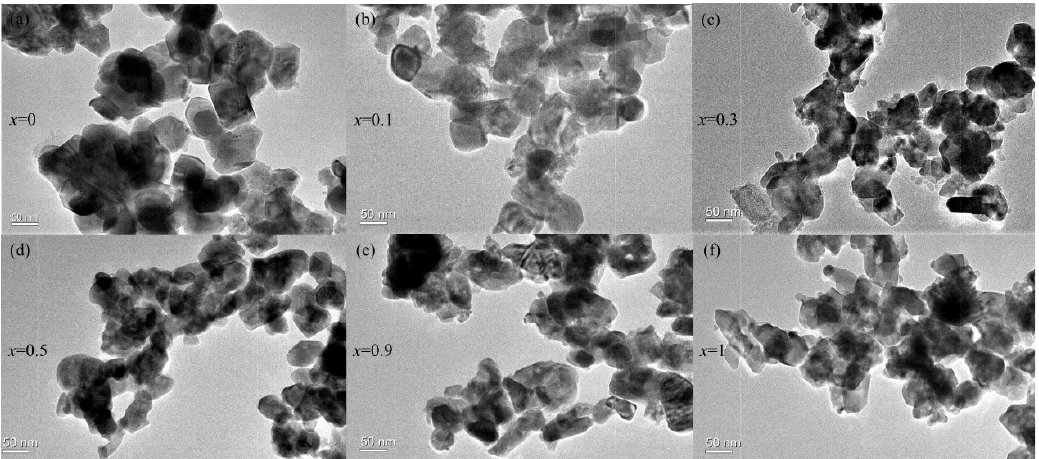
Figure 3. Transmission electron microscopy images obtained for ( a ) x =0, ( b ) x =0.1, ( c ) x =0.3, ( d ) x =0.5, ( e ) x =0.9 and ( f ) x =1 of Lu x Gd 1 − x VO 4 nanocrystals.